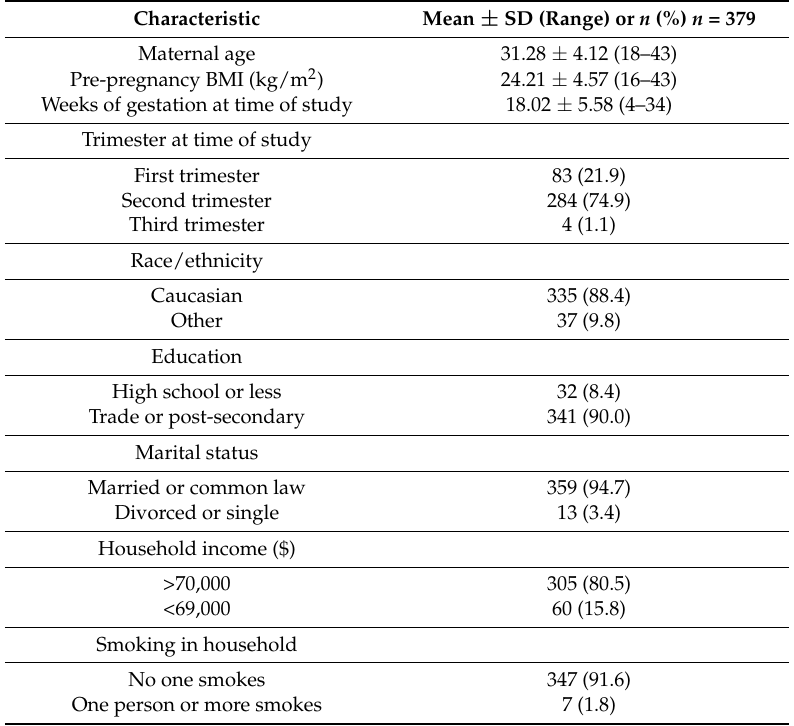
Table 2. Characteristics of pregnant women in the Alberta Pregnancy Outcomes and Nutrition (APrON) Study included in this analysis. BMI: body mass